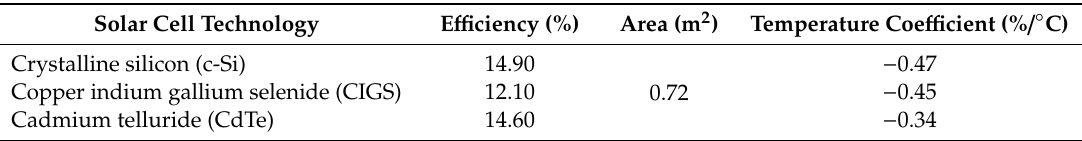
Table3. Powerperformancemodelingspecificationofthechosensolarcelltechnologiesasaphotovoltaic leaf for the solar photovoltaic tree